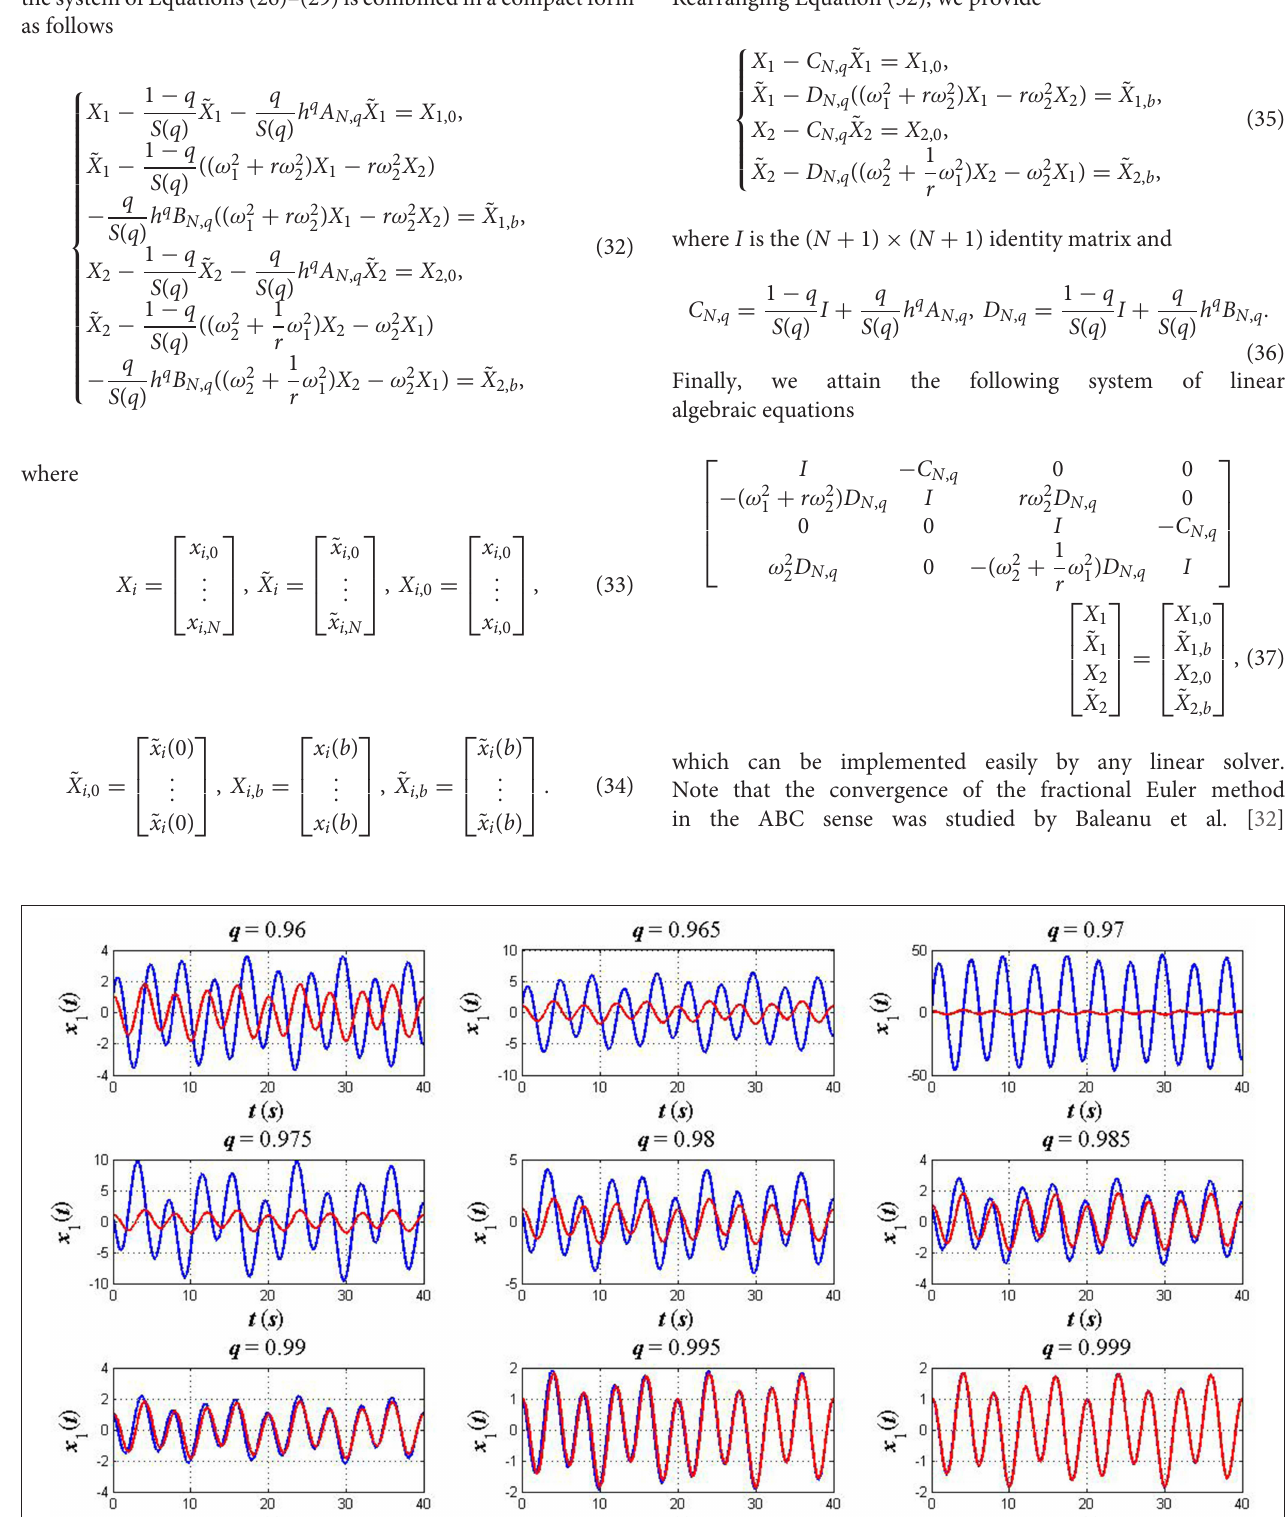
Frontiers in Physics |